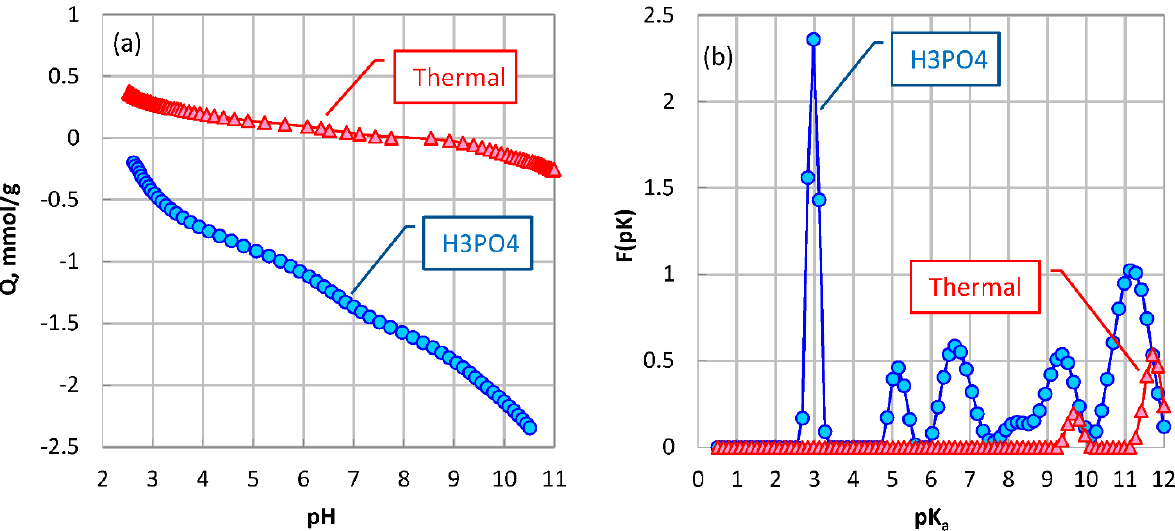
Figure 9. Proton-binding isotherms ( a ) and proton affinity distributions ( b ) for polyimide-derived carbons obtained with (H 3 PO 4 series) and without (Thermal series) phosphoric acid at 800 °C.